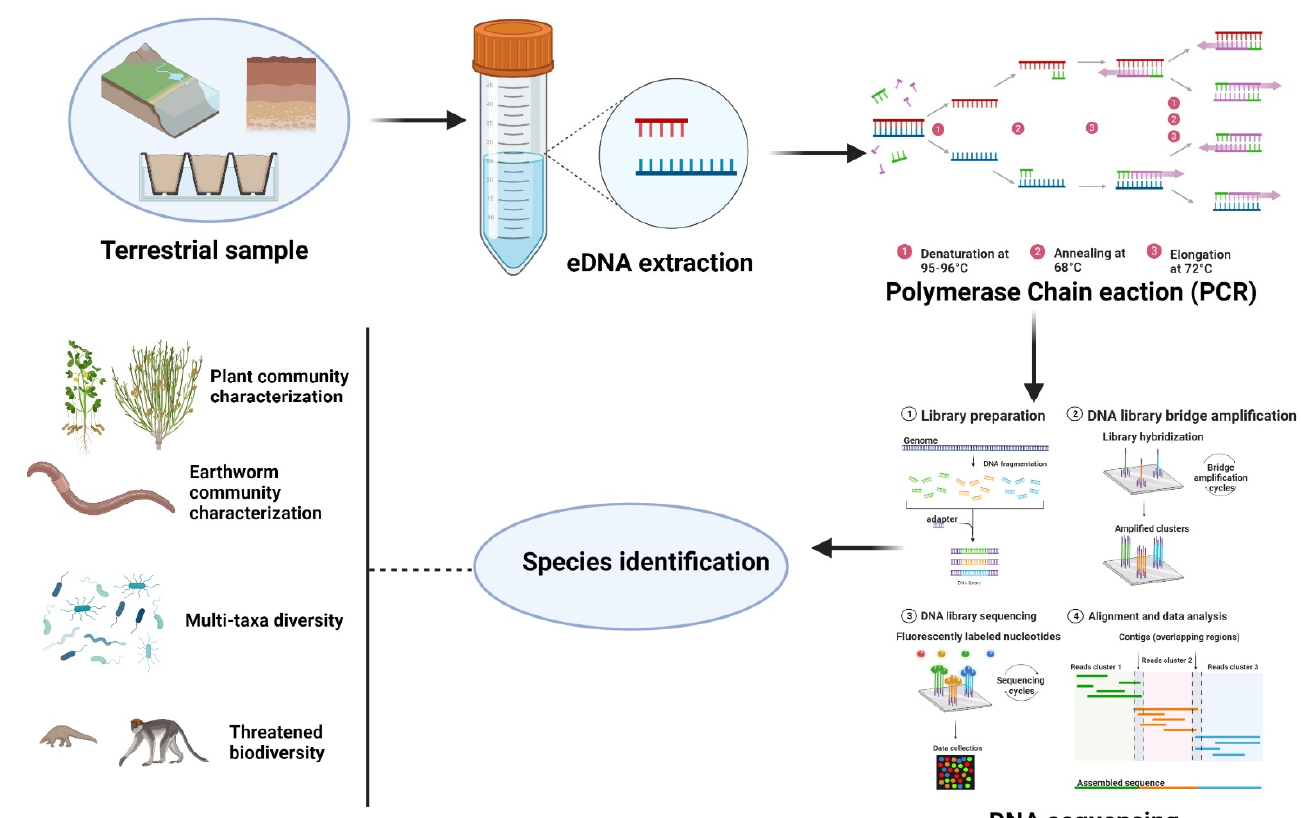
Figure 2. Environmental DNA in terrestrial ecosystems for biodiversity characterization.